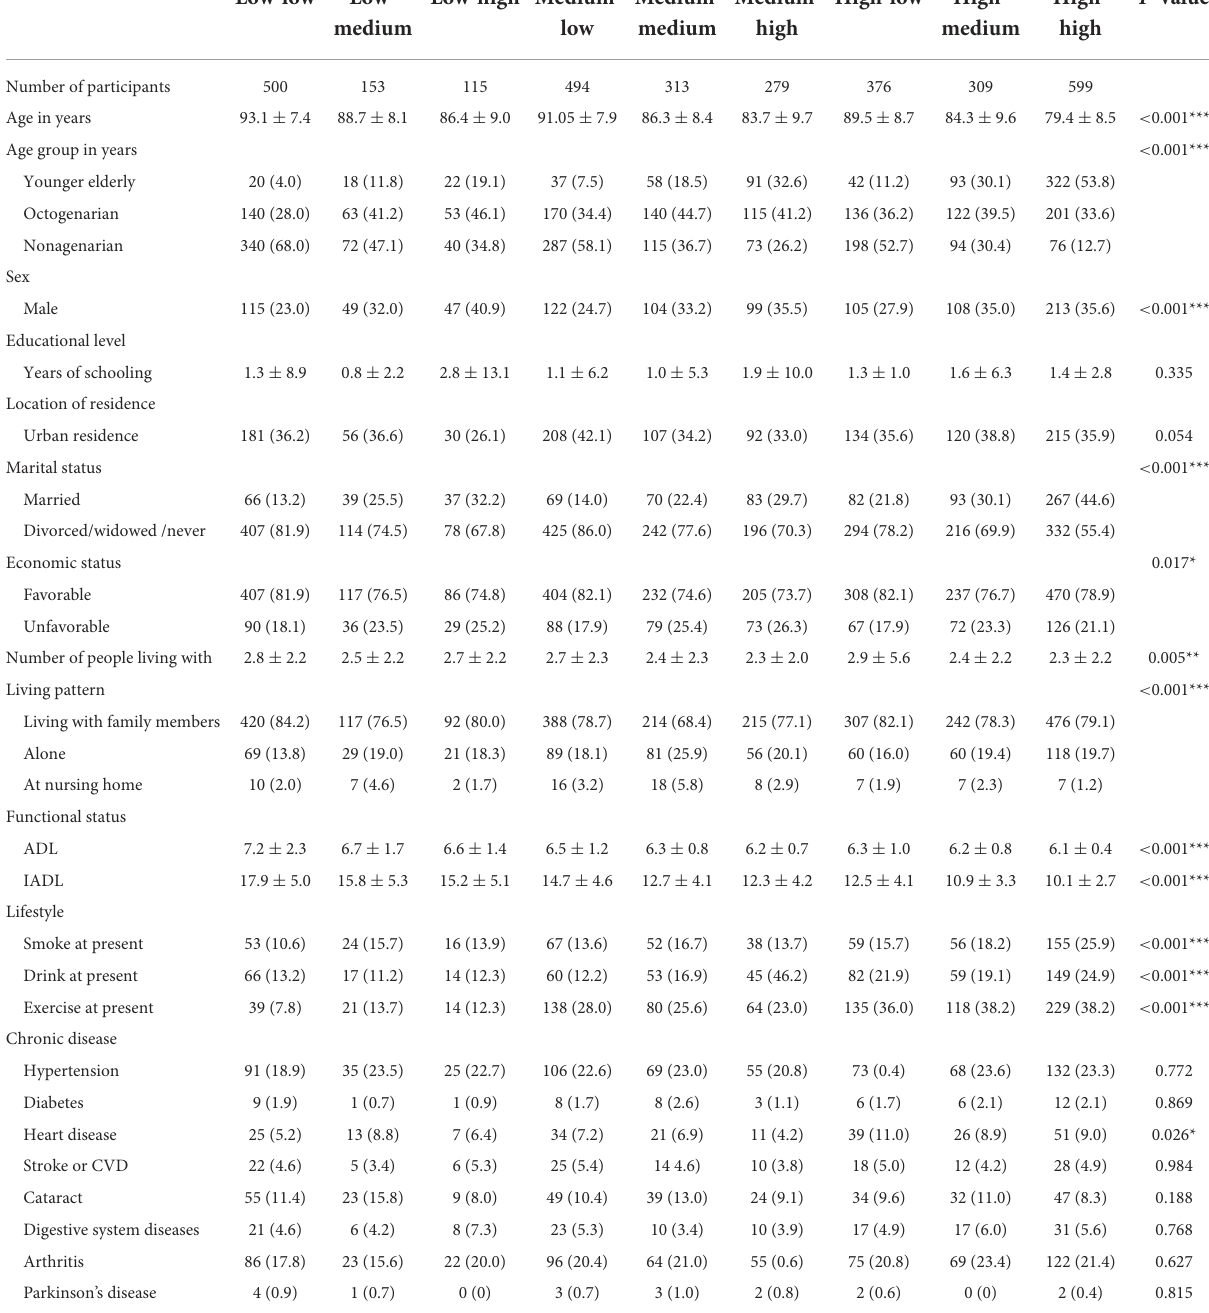
TABLE 1 Baseline characteristics of older adults according to LAE change patterns.